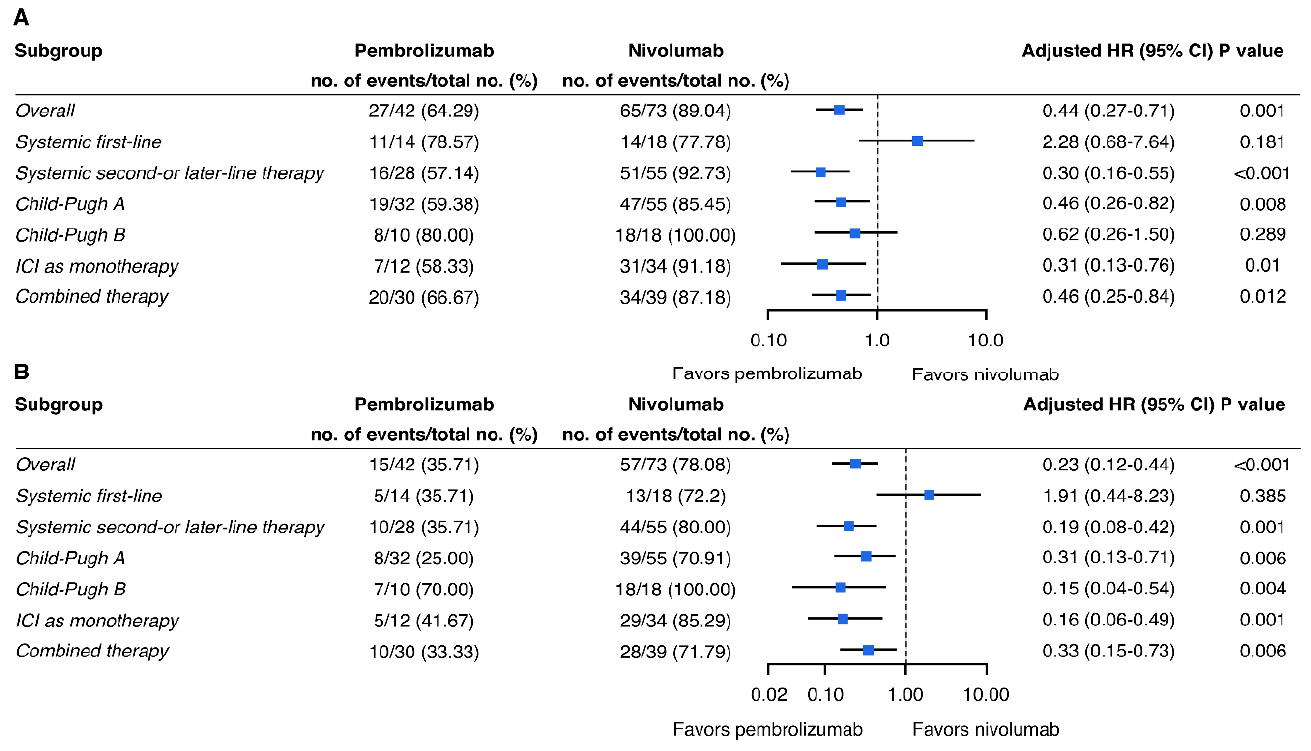
Figure 3. Hazard ratios (HR) of progression-free survival ( A ) and overall survival ( B ) for patients receiving pembrolizumab versus nivolumab. Squares represent subgroup-specific pooled HRs. Horizontal lines indicate a 95% confidence interval (CI).